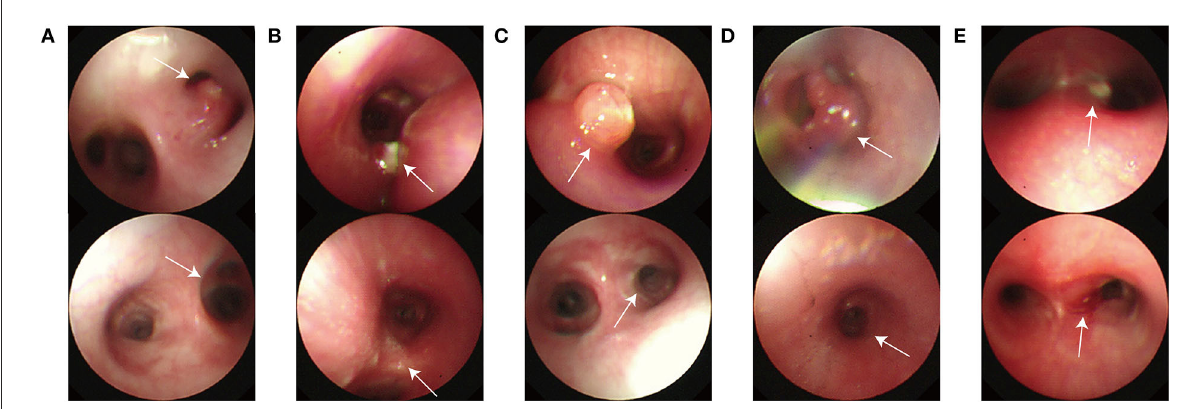
FIGURE1 Bronchoscopic manifestations before interventional therapy and after 3 months of the first interventional therapy. (A) The pre-intervention endoscopic presentation that localized tracheobronchial mucosa redness, hypertrophy, hyperplasia obvious and external pressure bulge without ulceration. (B) The pre-intervention endoscopic presentation that localized tracheobronchial mucosa redness, hypertrophy, hyperplasia obvious and external pressure bulge with caseous substance attachment. (C) The pre-intervention endoscopic presentation that granulation tissue with caseous material. (D) The pre-intervention endoscopic presentation that granulation tissue. (E) The pre-intervention endoscopic presentation that the caseous material overflow (top: before interventional therapy; bottom: after interventional therapy).